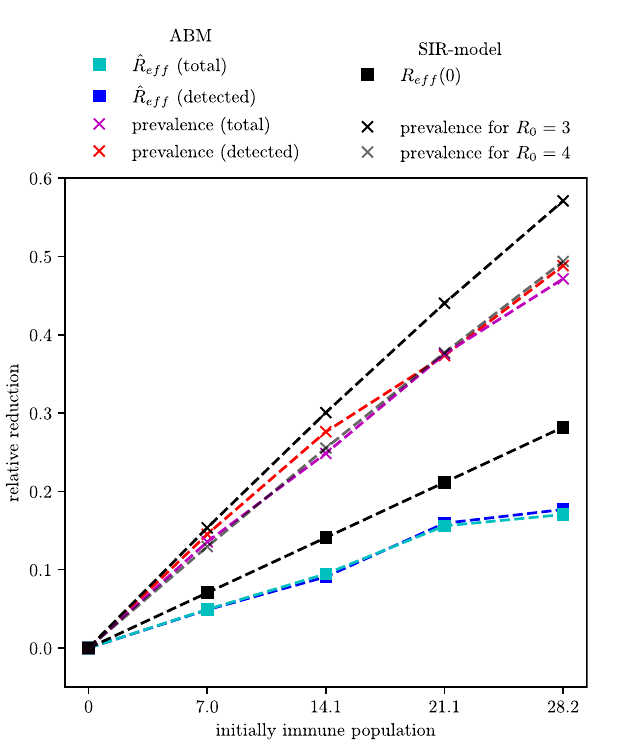
Figure 10. Relative reduction of the effective reproduction number and the peak of the prevalence compared to a fully susceptible population for the results of the classic SIR-model and of the agent-based simulation